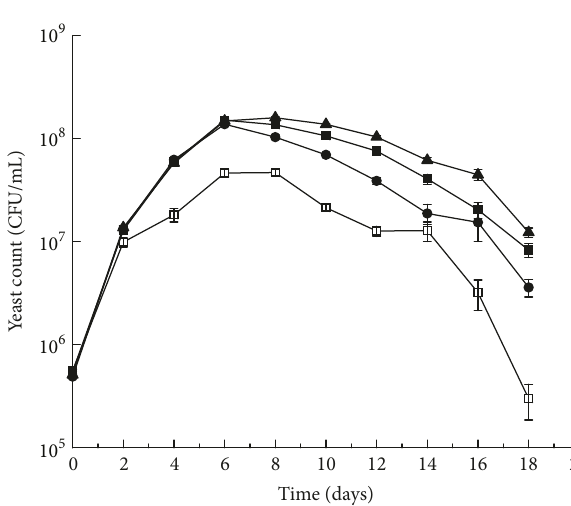
Figure 1: Growth of yeast cells of “Shuangyou” wines added with 20 ( e ), 60 ( ◼ ), and 100 ( 󳵳 ) g/L sucrose and controls ( ◻ ) during